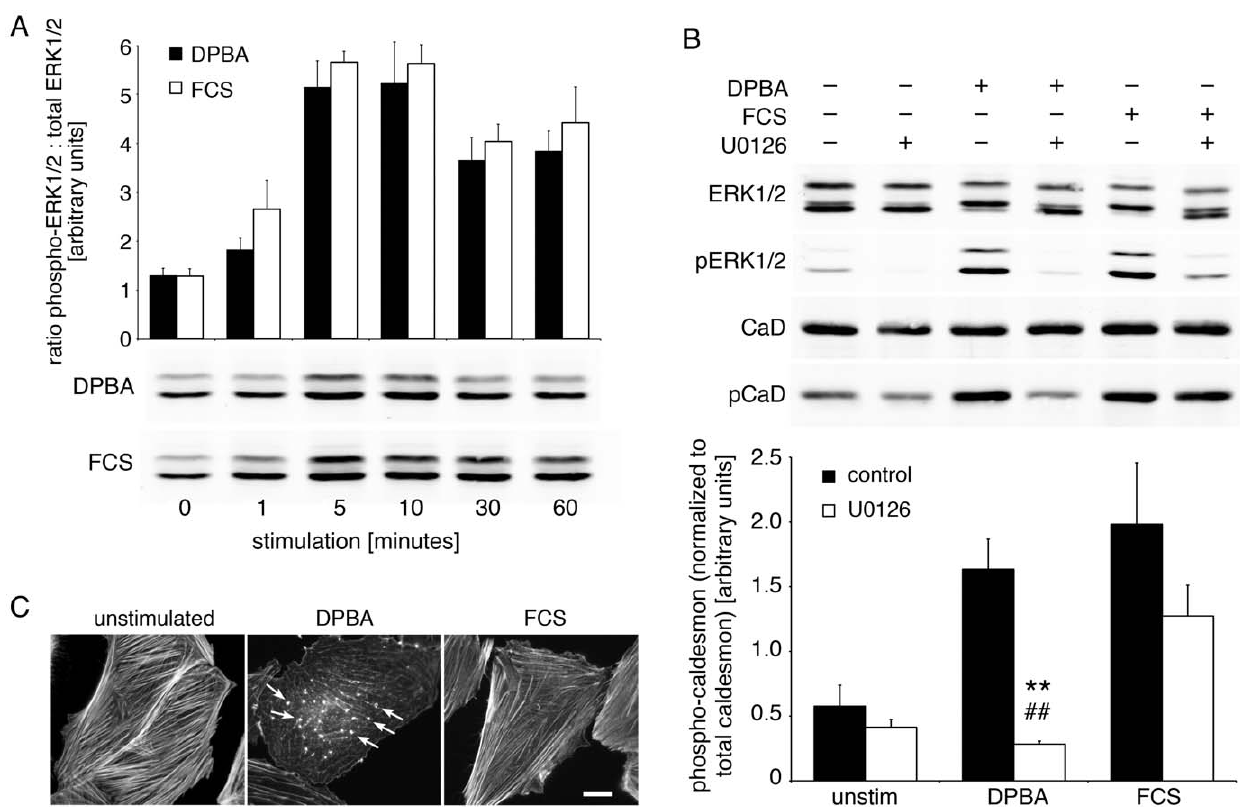
Figure 1. ERK1/2 activation has stimulus-specific effects on the A7r5 cytoskeleton. (A) ERK1/2 is phosphorylated in response to both, DPBA and FCS. A7r5 cells stimulated with either DPBA or FCS for the indicated time points were processed for western blot analysis of total ERK1/2 and phospo-ERK1/2. After densitometry analysis, no significant differences in ERK1/2 phosphorylation (normalized to total ERK1/2) were detected. (B) A7r5 cells were pre-treated with the MEK inhibitor U0126 for 60 minutes, then stimulated with DPBA or FCS, or left untreated, for additional 60 minutes before preparation of cell lysates. Lysates were analyzed by western blotting and densitometry. Please note that in the presence of the MEK inhibitor, caldesmon phosphorylation in response to DPBA is completely blocked, whereas caldesmon phosphorylation (normalized to tubulin) in response to FCS is reduced by only about 30%. Statistical significance was tested by a two-tailed Student’s T-Test (**p , 0.01 U0126 vs. control, ## p , 0.01 DPBA vs. FCS). (C) A7r5 cells grown on coverslips were treated as indicated for 60 minutes, then fixed and stained for fluorescence microscopy with phalloidin to visualize actin filaments. Please note the cytoskeletal rearrangements and the appearance of podosomes in the DPBA treated cells (arrows). Scale bar, 20 m